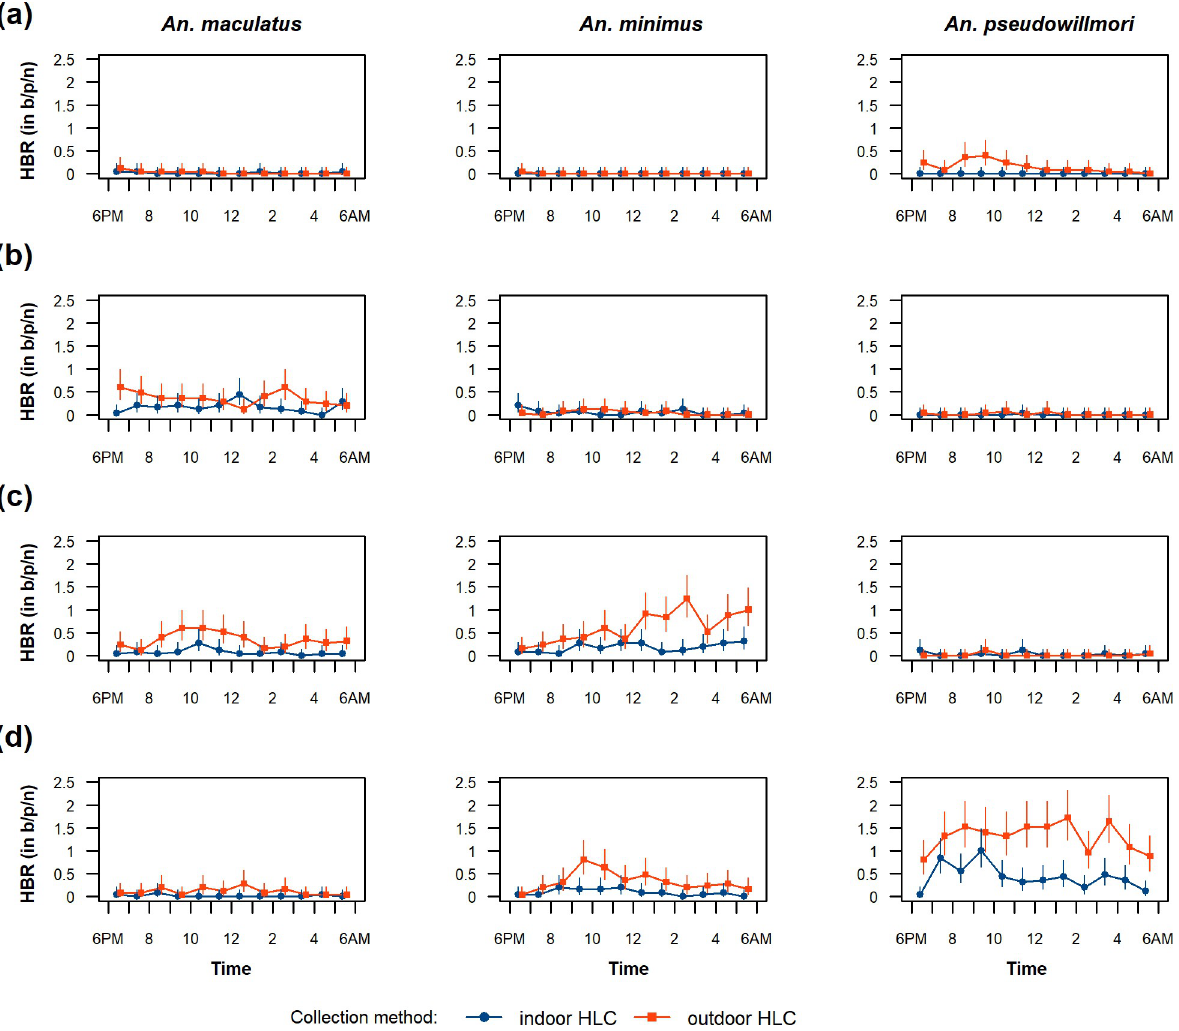
Fig 2. Hourly biting pattern of malaria mosquitoes at baseline. (a) KM-500. (b) KP-506. (c) MK-509. (d) SP-513. Error bars indicate exact Poisson 95% CIs. Abbreviations : b/p/n: bites /person /night; CI, confidence interval; HLC, human-landing